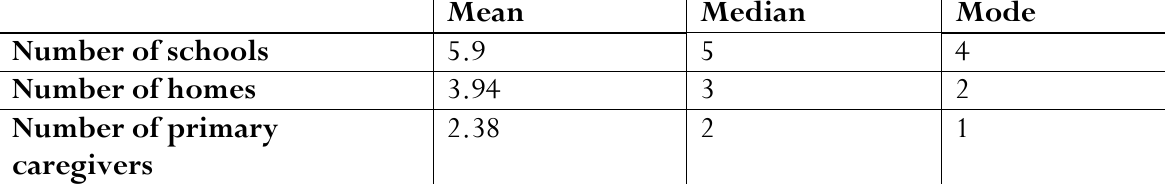
Appendix Table 1: Mean, Median, & Mode for Childhood Stability